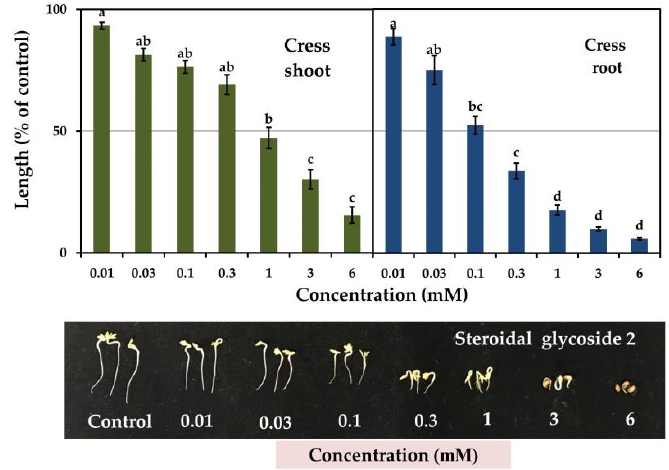
Figure 7. Inhibitory activity of compound 2 on the shoot and root growth of cress. The bars on each experiment express mean ± SE with three replicates ( n = 30). Different letters indicate significant differences among the treatments (Tukey’s HSD, p < 0.05).